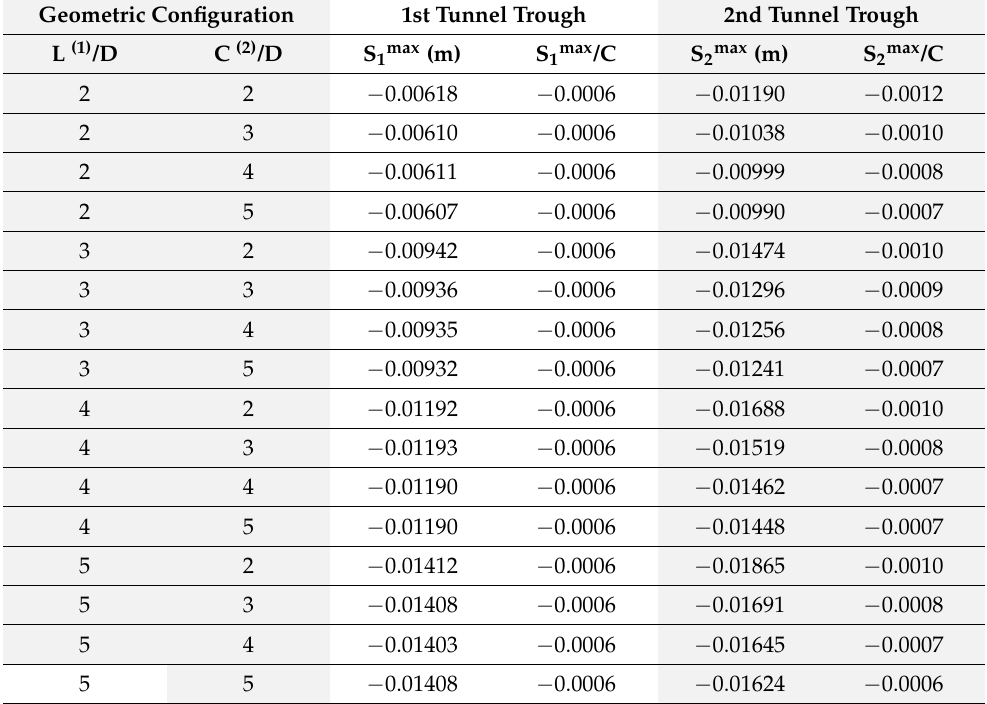
Table 3. Numerical analyses of maximum settlement.